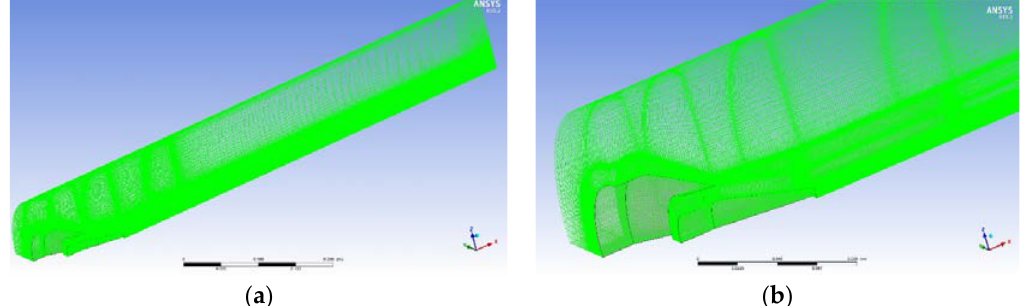
Figure 5. The mesh for the entire flow domain with ejector ( a ) and detail ( b ).